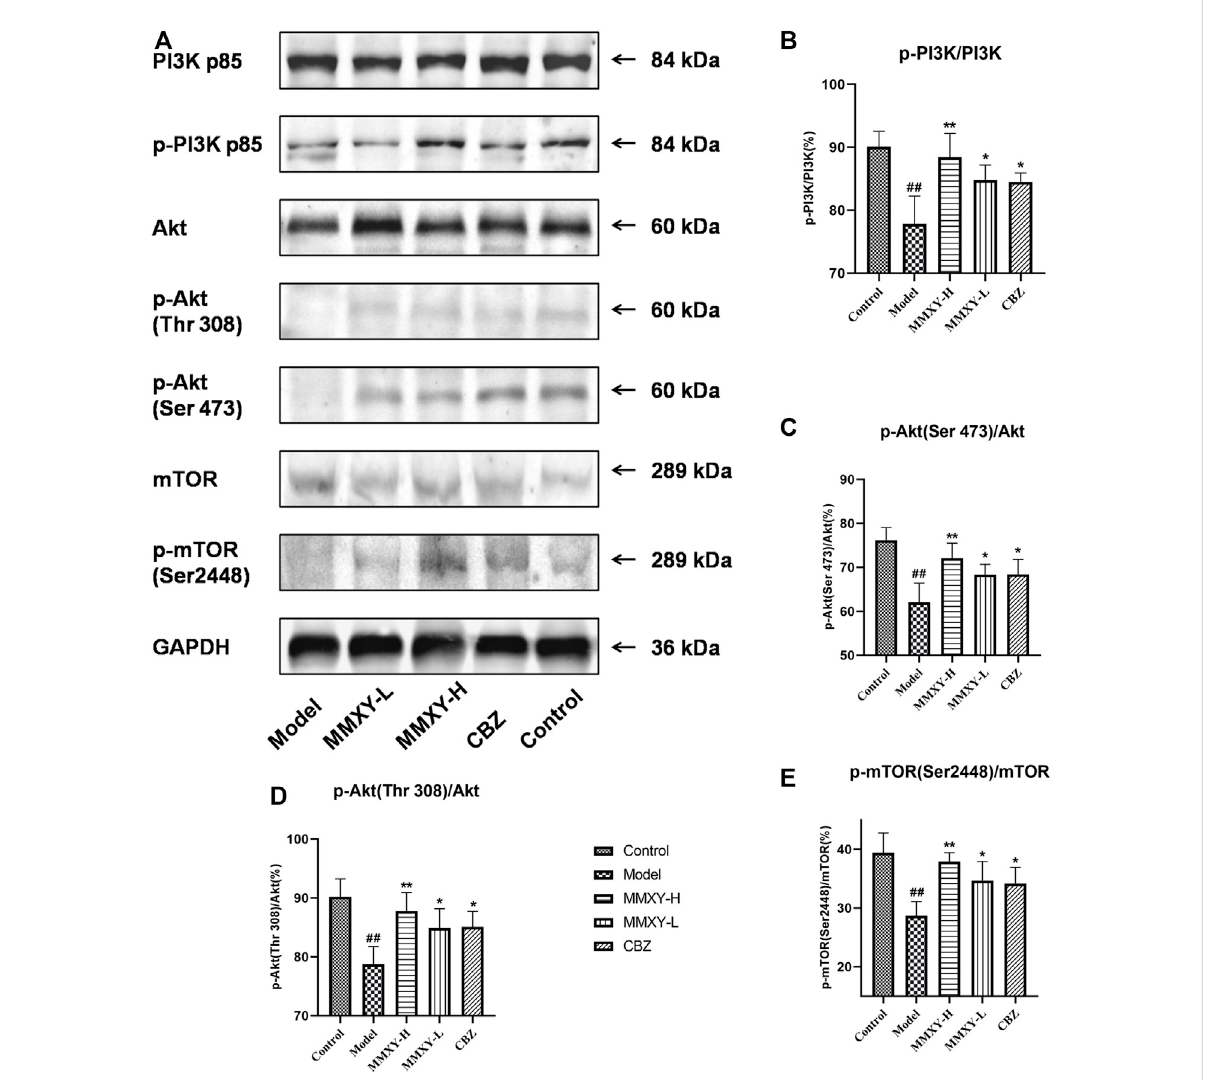
FIGURE 11 Effects of MMXY on protein expression of PI3K/Akt/mTOR pathway in retina of CUMS rats. (A) Representative images of Western blot showing PI3K p85, p-PI3K p85, Akt, p-Akt (Thr308), p-Akt (Ser473), mTOR, p-mTOR (Ser2448) expression in the retina of each group. GAPDH was used to con fi rm an equal amount of protein (n = 3). (B – E) Quantitative expression of p-PI3K/PI3K, p-Akt (Ser473)/Akt, p-Akt (Thr308)/Akt, p-mTOR (Ser2448)/mTOR in each group. # p < 0.05 and ## p < 0.01 vs. control group; * p < 0.05 and ** p < 0.01 vs. model